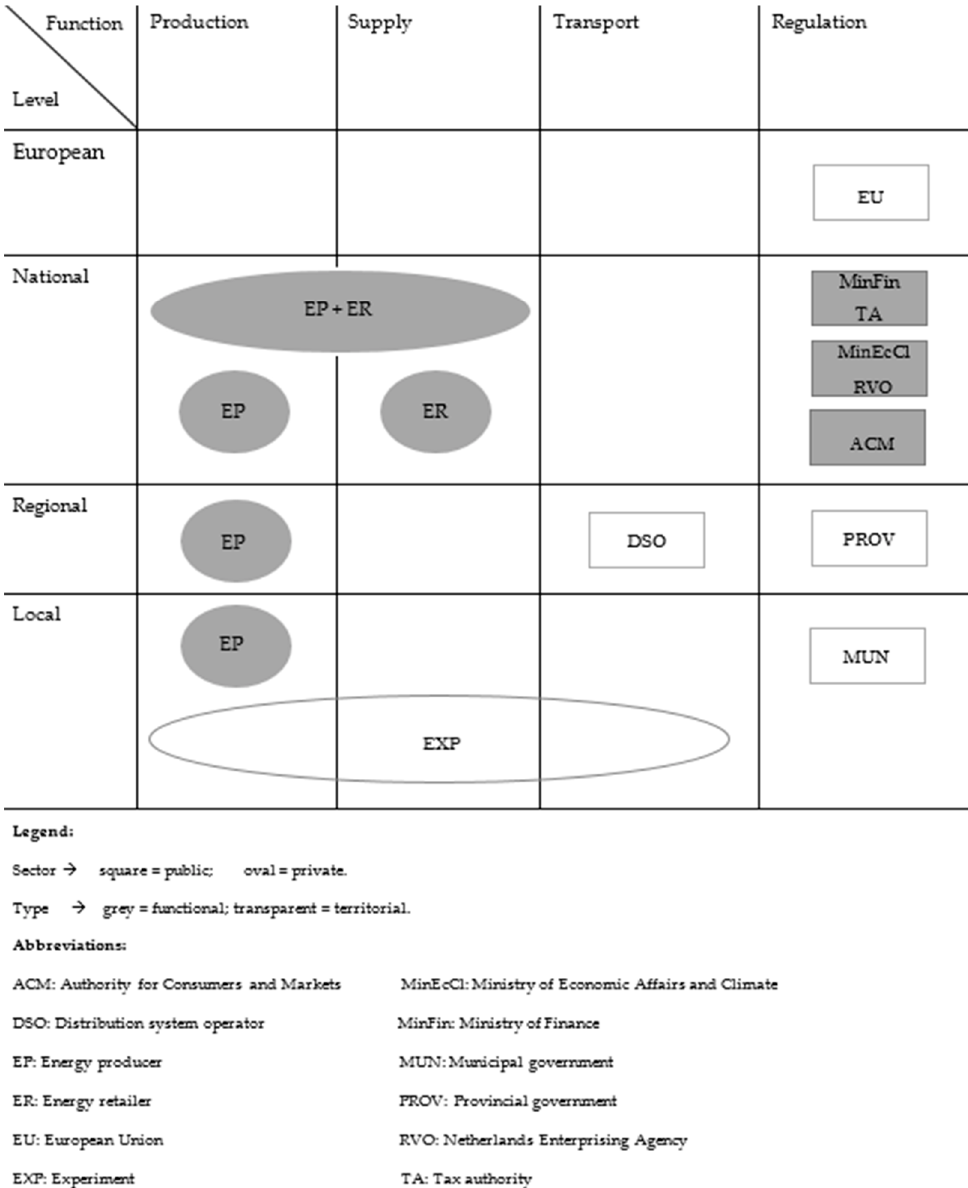
Figure 1. Overview of polycentric energy system under the EDSEP.